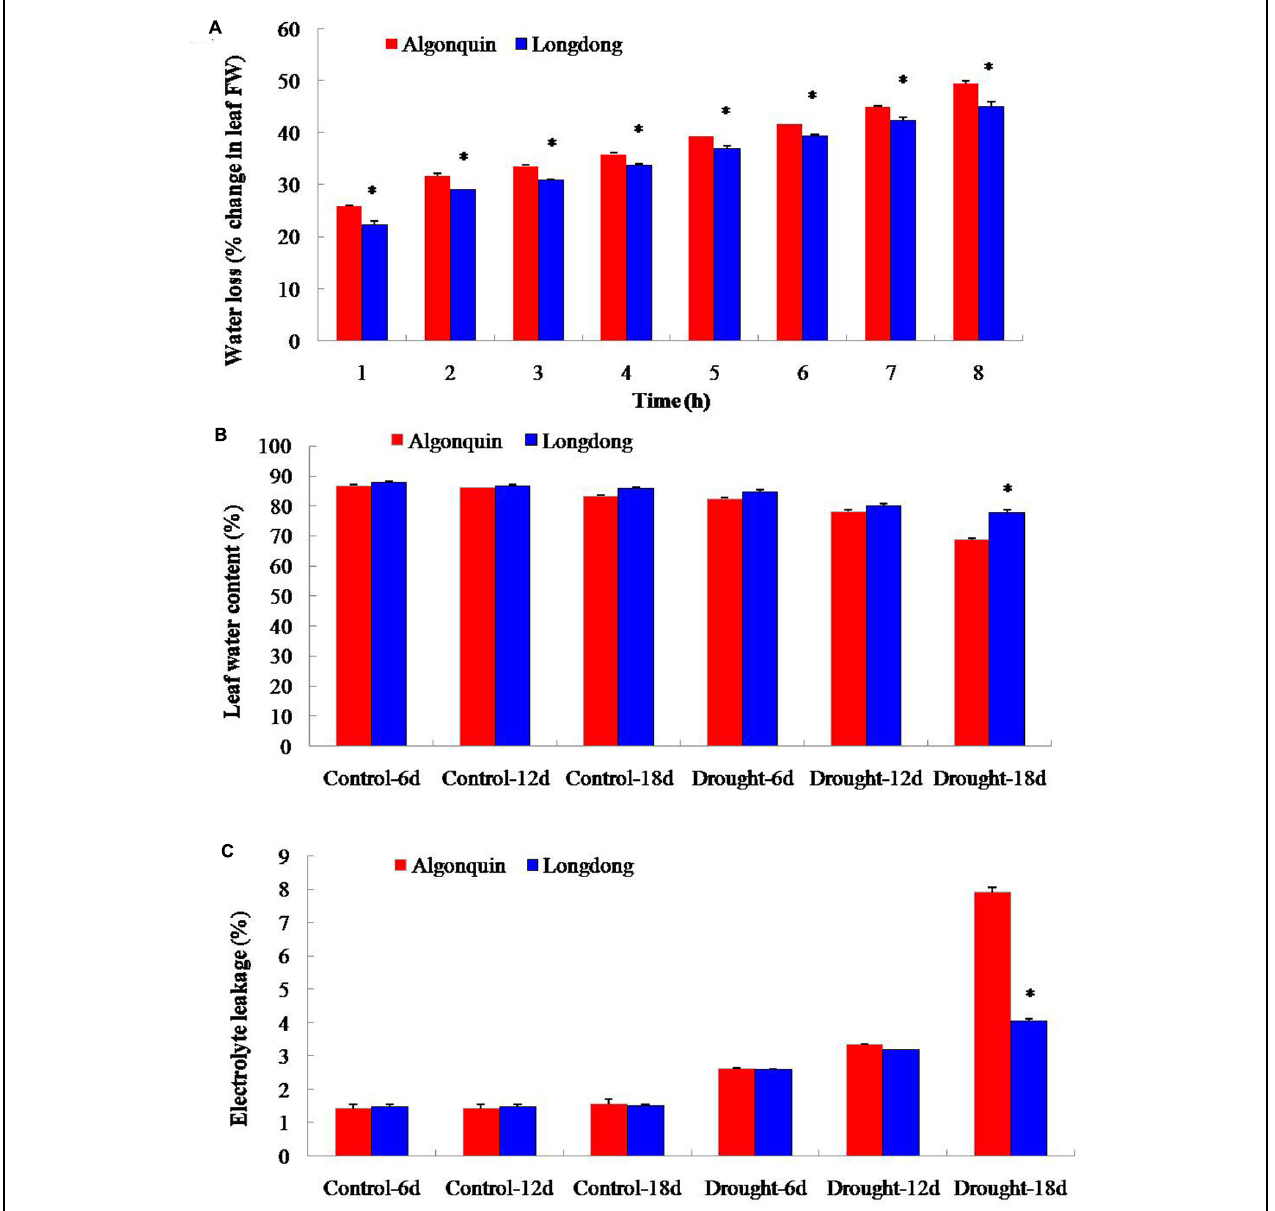
FIGURE 1 | Quantitative comparison of water status and electrolyte leakage (EL) of two alfalfa varieties differing in drought tolerance. (A) At drought stress 12 days, water loss of Algonquin and Longdong was compared under control condition. (B) LWC under control and drought conditions. (C) EL under control and drought conditions. The results shown are means ± SE ( n = 5). Asterisk symbols indicate significant differences from Algonquin at P < 0.05 (Student’s t -test).